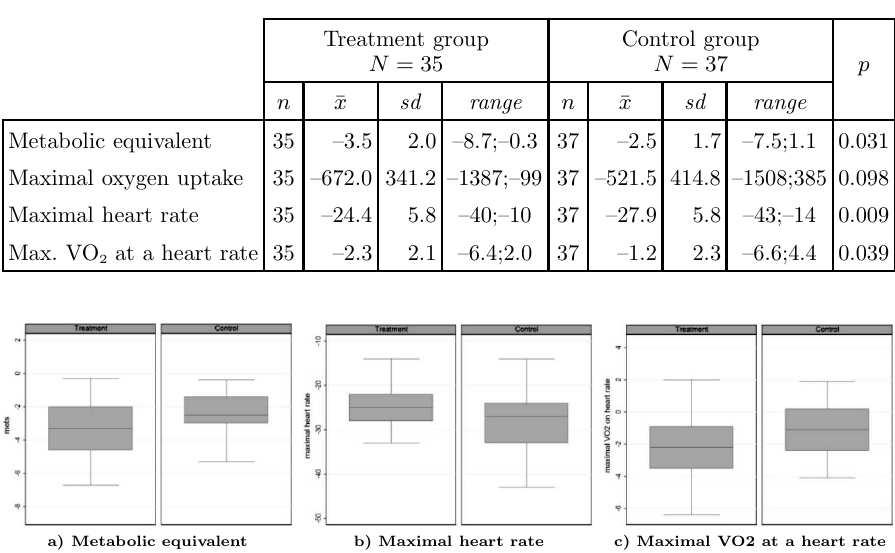
Figure 1. Box plots for three parameters for the treatment group and the control